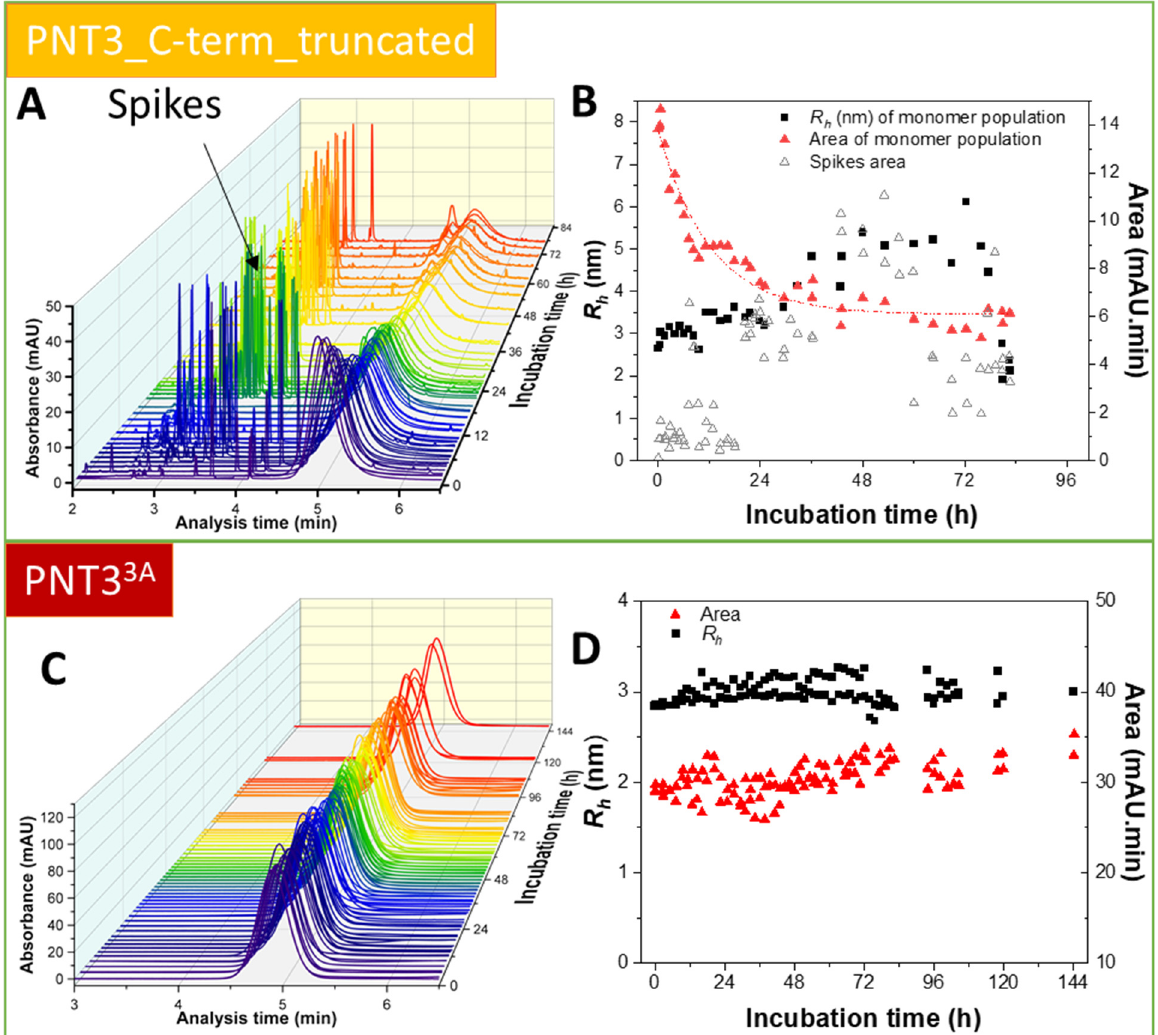
Figure 8. Kinetics of fibril formation by Taylor Dispersion Analysis (TDA). Three-dimensional overview of the obtained taylorgrams during the aggregation process of HeV PNT3-Cterm_truncated ( A ) and HeV PNT3 3A ( C ) at different incubation times. The rainbow color code indicates the progress of the incubation time from dark violet to red. Analyses were performed using a protein concentration of 200 μ M in 50 mM phosphate buffer, pH 7.2 at 37 °C. Peak area and hydrodynamic radius ( Rh ) evolution of the monomeric species and of the spikes area during the aggregation process of HeV PNT3-Cterm_truncated ( B ) and HeV PNT3 3A ( D